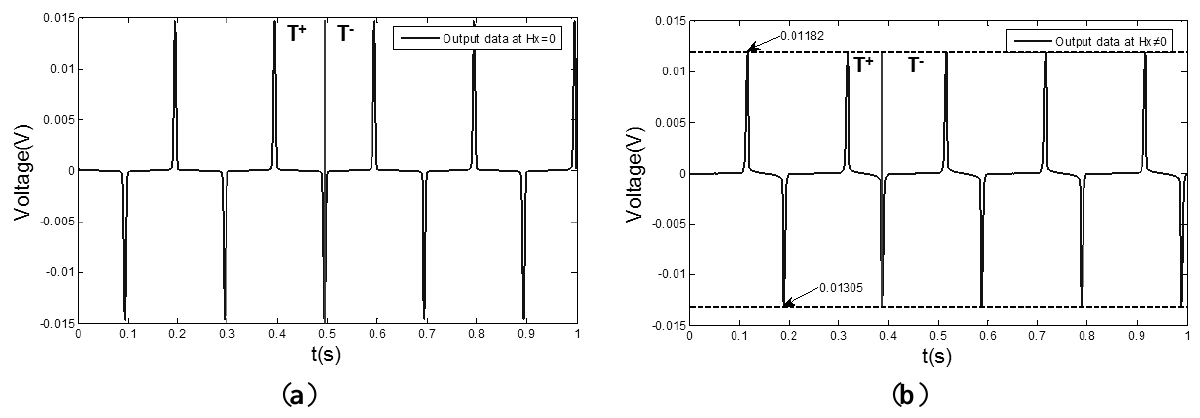
Figure 3. The output signal of the sensor: ( a ) there is an external magnetic field; ( b ) there is no external magnetic